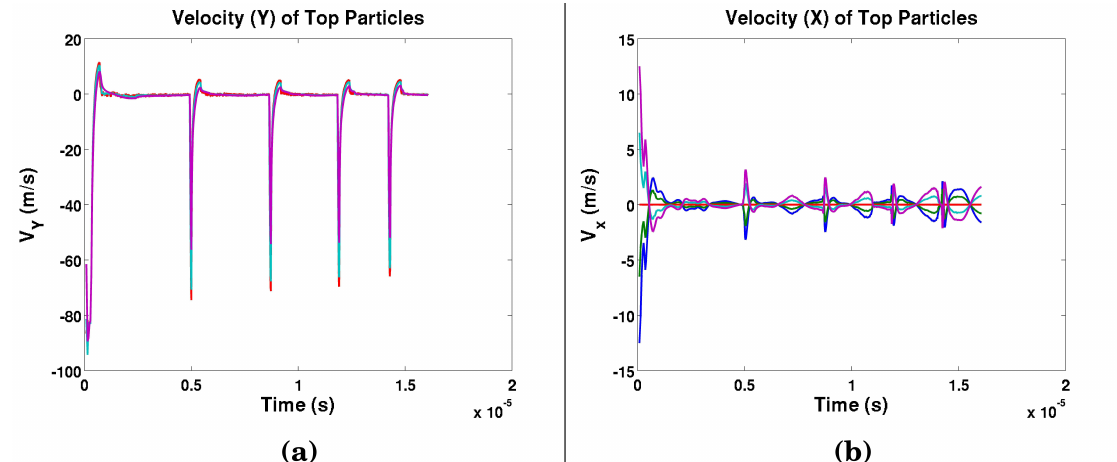
Figure 5. The velocity change, where each line represents the velocity of a specific mass particle in the ( a ) y and ( b ) x direction, for the top five center-most particles.